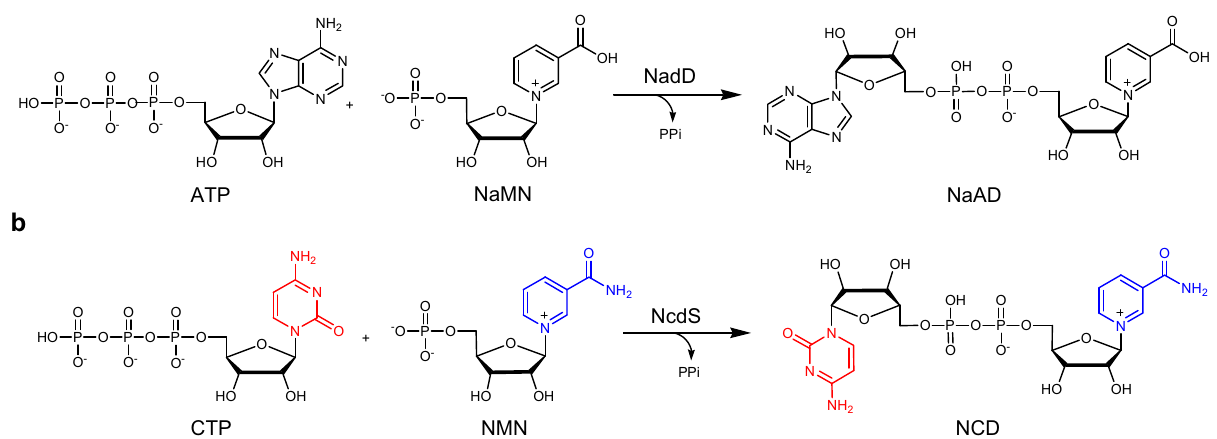
Fig. 1 Structures and enzymes for cofactor biosynthesis. a Native NadD catalyzed synthesis of NaAD from ATP and NaMN. b The proposed NcdS to catalyze the condensation of CTP and NMN into